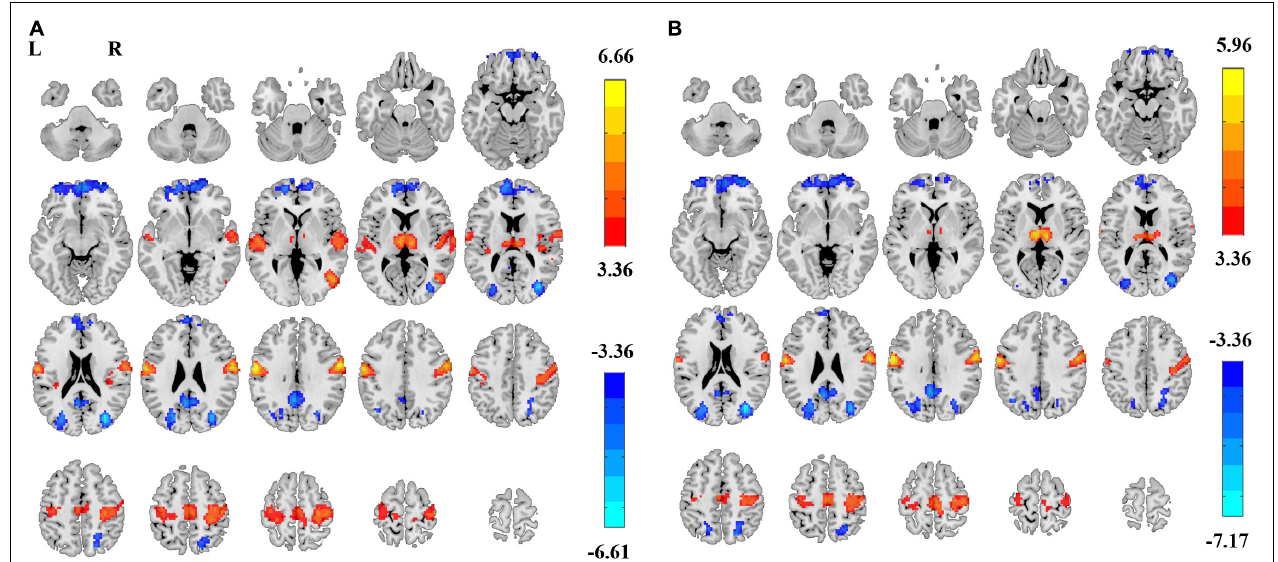
FIGURE 5 | ALFF differences between EC and EO. Significant difference of ALFF between EC and EO conditions in frequency bands of 0.01–0.1 Hz [Panel (A) , GRF correction, P corrected < 0.05, |T| > 3.36, cluster size > 89 voxels] and 0.01–0.25 Hz [Panel (B) , GRF correction, P corrected < 0.05, |T| > 3.36, cluster size > 83 voxels]. L, left; R,